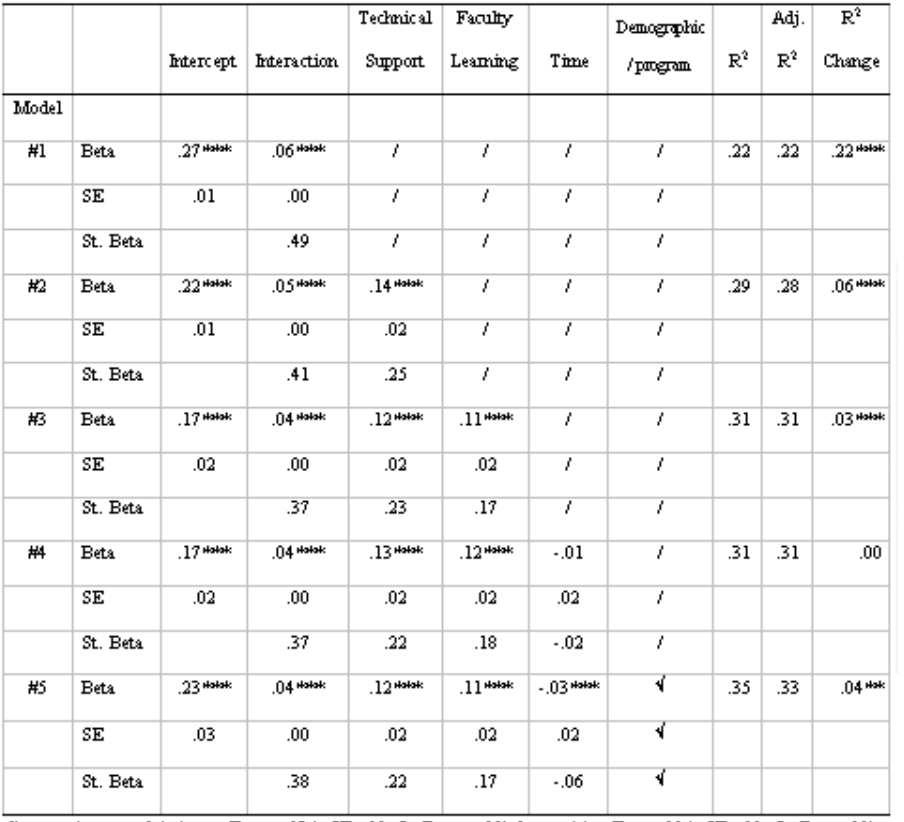
Table 8. Sequential Regression on Faculty Online Teaching